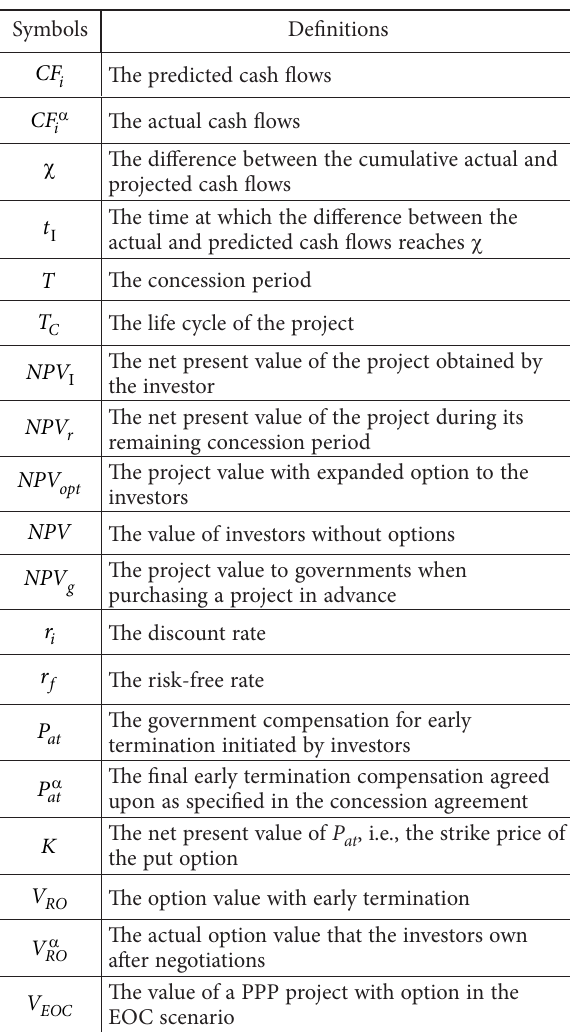
Table 2. The definitions of variables related to project value model with investors’